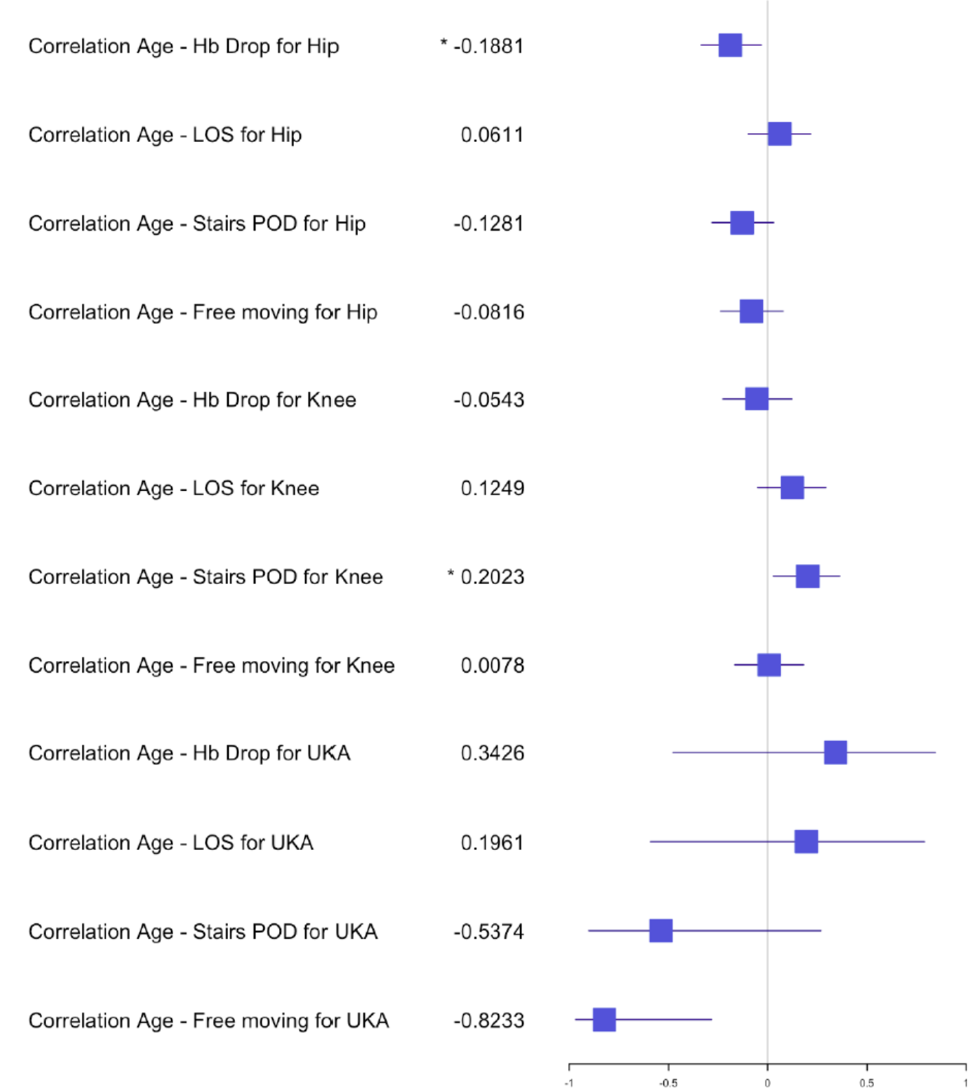
Figure 5. Forest plot for the effects of age on Hb drop, LOS and functional outcome for staged arthroplasty. (*) significant results.